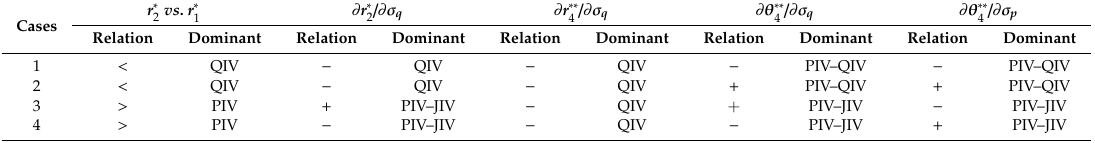
Table 5. Optimal pricing and hedging behaviors and their dominant volatility